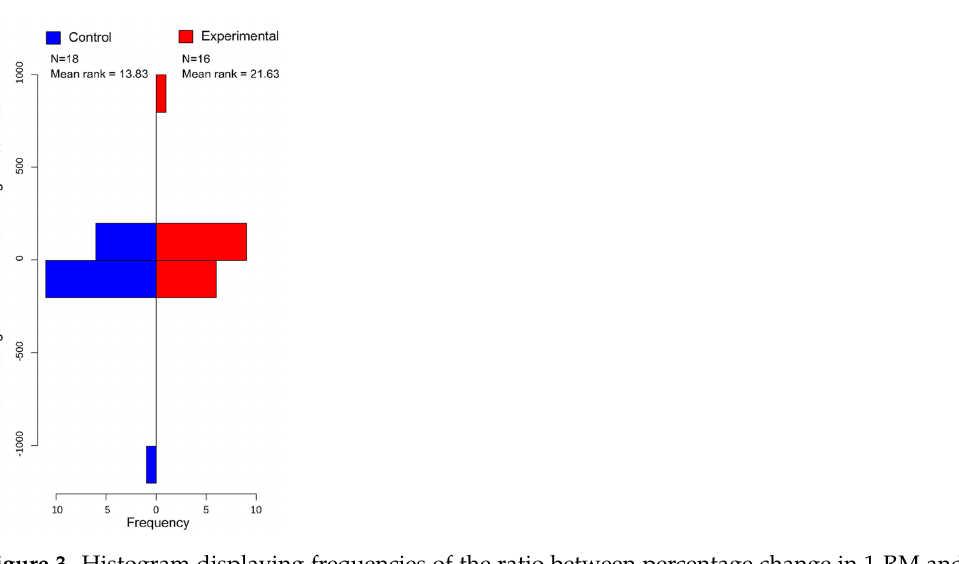
Figure 2. Histogram displaying frequencies of the ratio between change in 1-RM and change in lean mass between the control and experimental group. Ranking was performed for use in the Mann–Whitney U test.